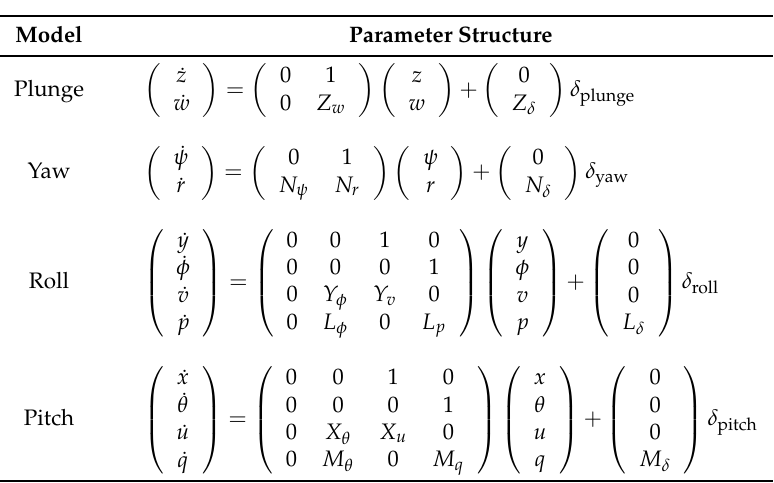
Table 3. The plunge, yaw, roll and pitch model structures of the quadrotor determined from system identification flight experiments and step-wise regression algorithm presented in [51].